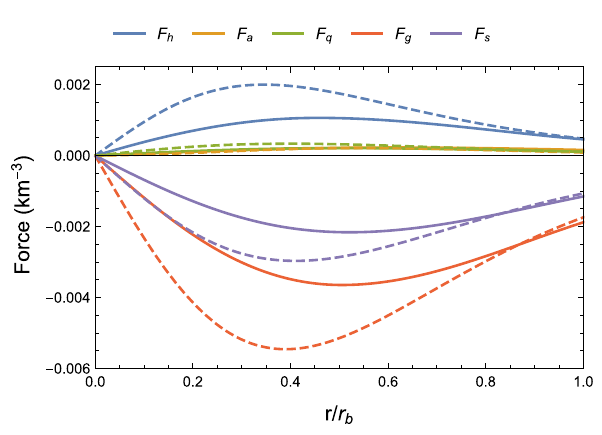
Fig. 5 Force profiles at f = f bh for K = − 2 (solid) and K = − 20